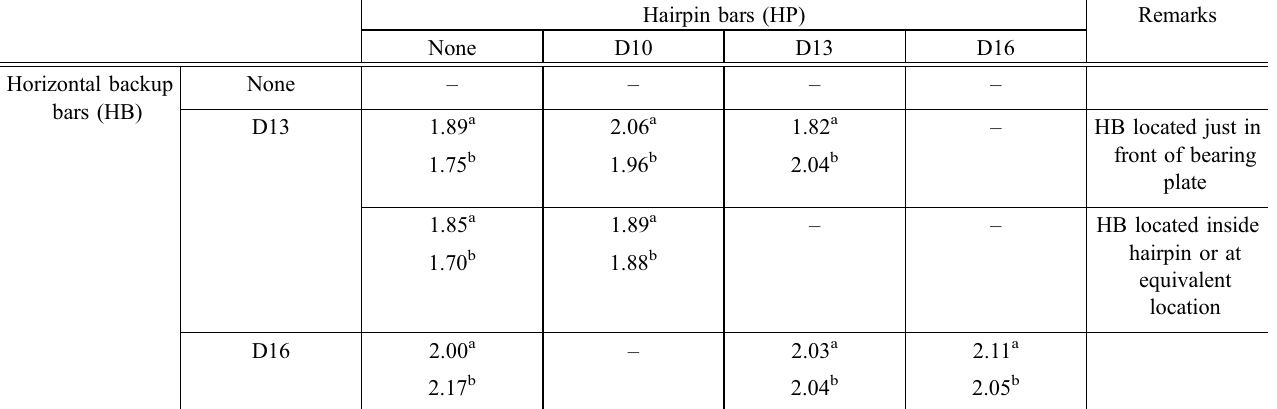
Measured concrete strength at testing day. a